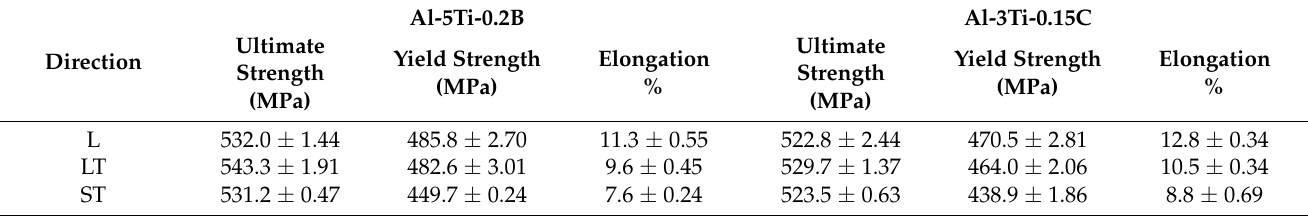
Table 3. Tensile Properties for 7050-T7651 100 mm Plate with Different Grain Refiners.